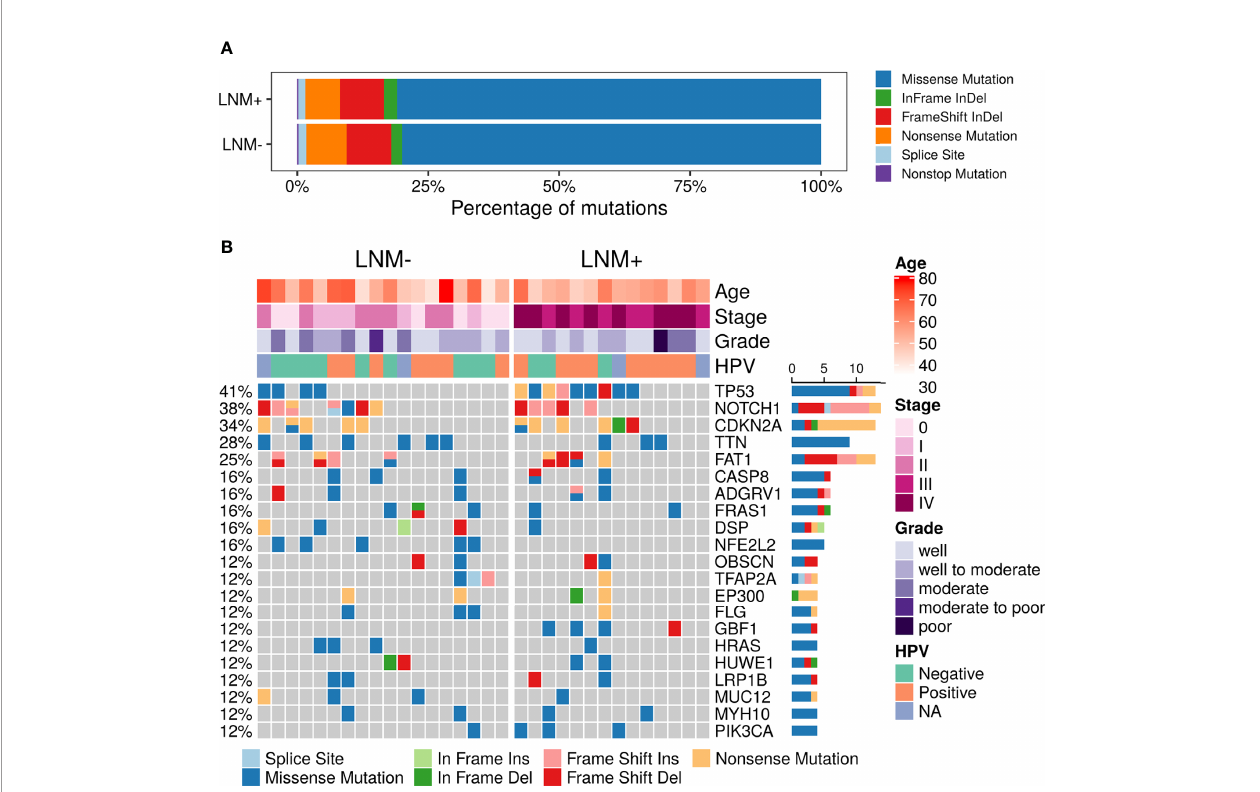
FIGURE 1 | Summary of somatic mutations in 32 PSCC patients. (A) The frequencies of different variant types in lymph node metastasis (LNM) involved patients and negative-node patients. (B) Mutational landscape of all 32 PSCC patients. Each row represents one gene while each column represents one patient. The frequencies of gene mutants and clinical characteristics are labeled by the side of the heatmap. (NA, not